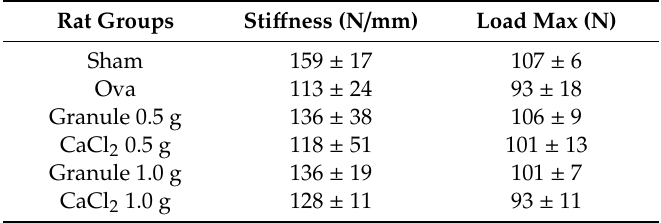
Table 3. Sti ff ness and breaking load data for rat femurs. Means ± Table 3. Stiffness and breaking load data for rat femurs. Means ± SD.